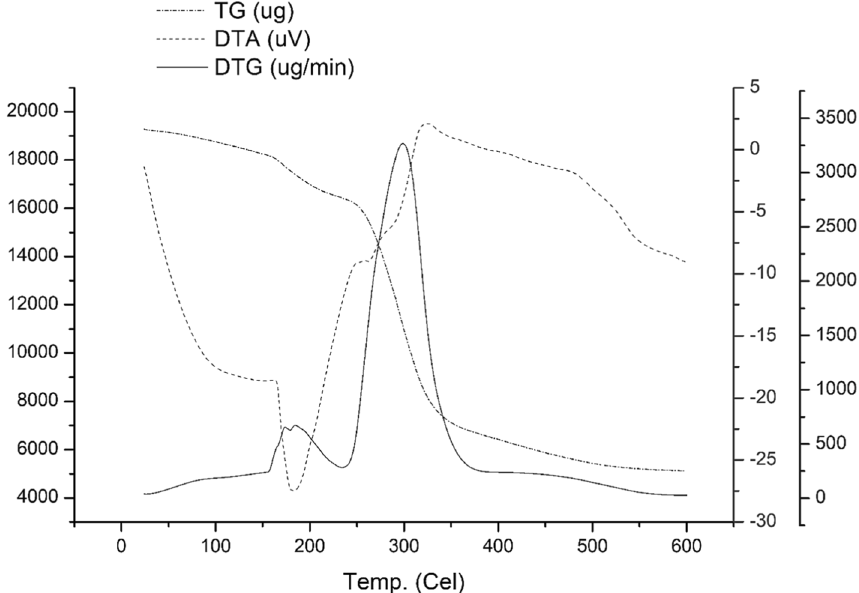
Fig. 3 Thermal Properties of the Modified Starch [Sam- ple 4: it was made using 2% Sodium Hydroxide and 1% Adipic Acid and 1% Mustard Oil (all materials were taken on the weight of